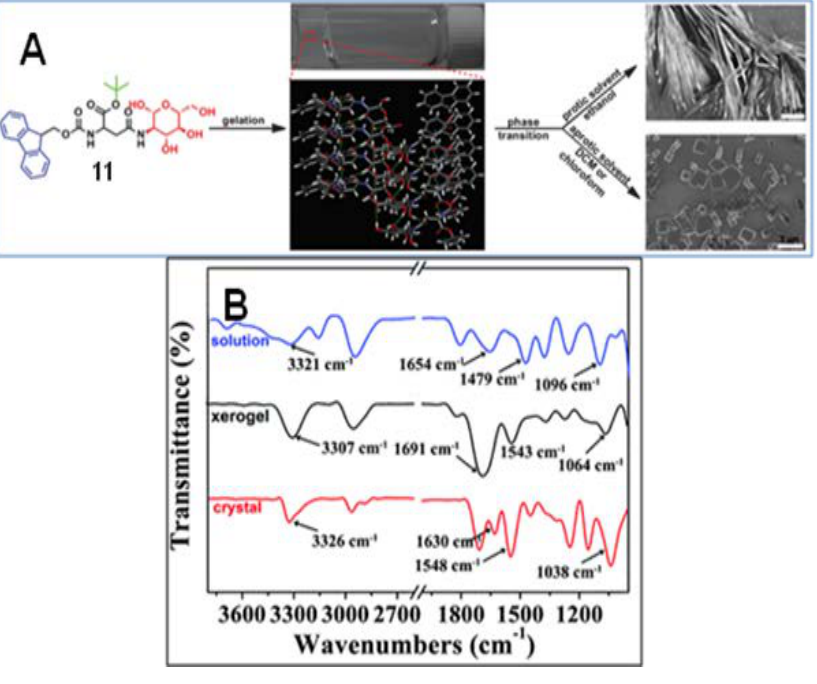
Figure 9. ( A ) Illustration of the self-assembly of Fmoc-Asp(Glc)-OtBu ( 11 ) in 1D microfibers and 3D microcubes in both protic and aprotic solvents; ( B ) FTIR analysis of the xerogel, microcrystals and solution in dichloromethane (DCM) (1.5 wt %). Reprinted with permission from [72]. Copyright 2016 Royal Society of Chemistry.